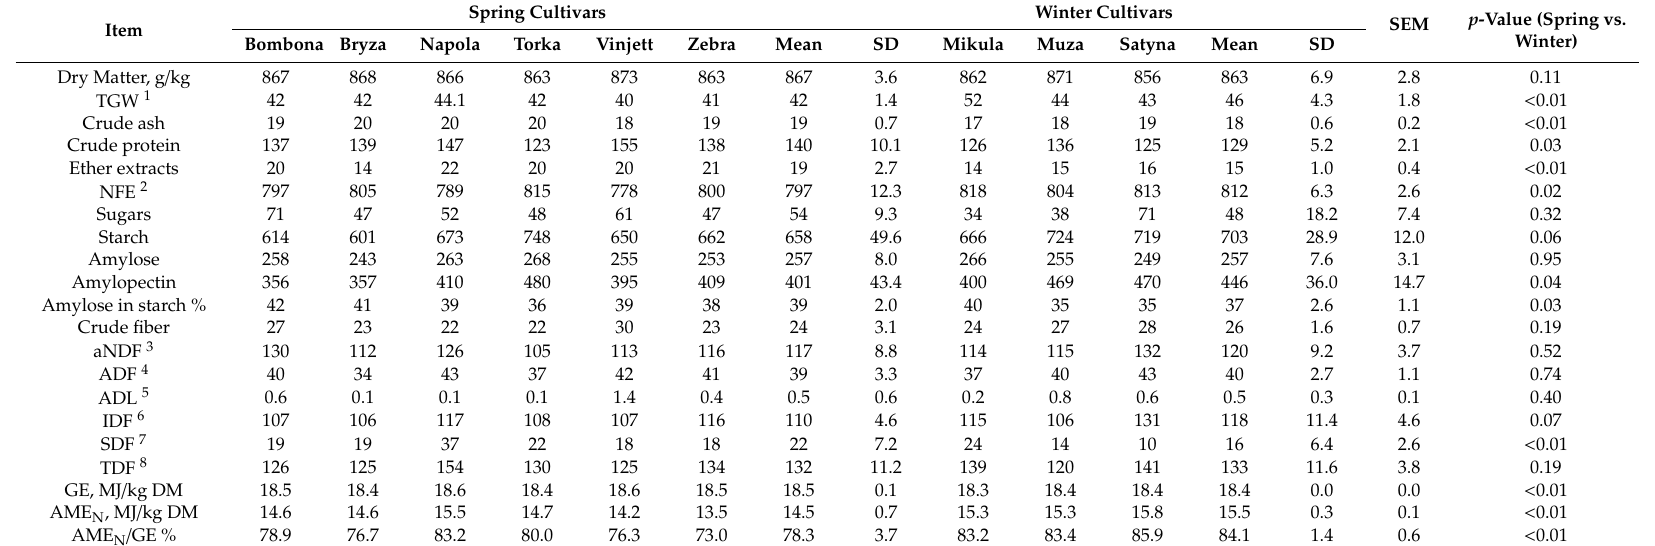
Table 2. Chemical composition (g / kg, dry matter—DM), gross energy (GE), and apparent metabolizable energy content (AME N ) of wheat